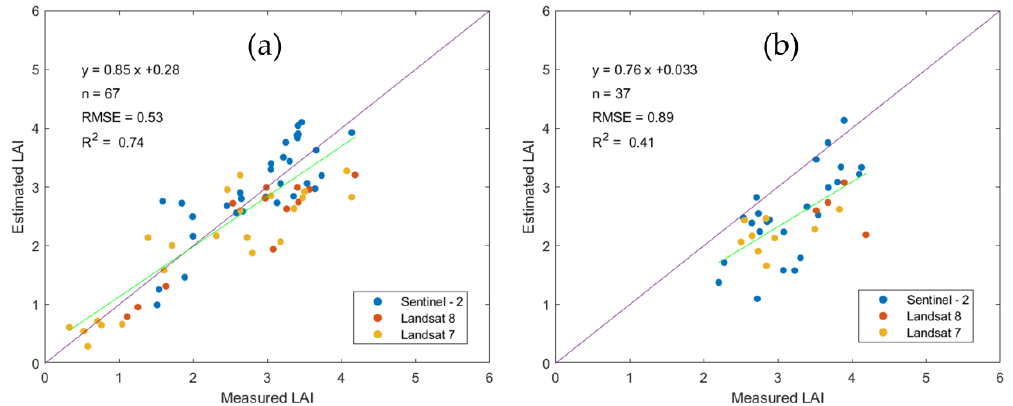
Figure 12. Comparison between measured and estimated LAI ( a ) before and ( b ) after DOY (i.e., day of year) 212.